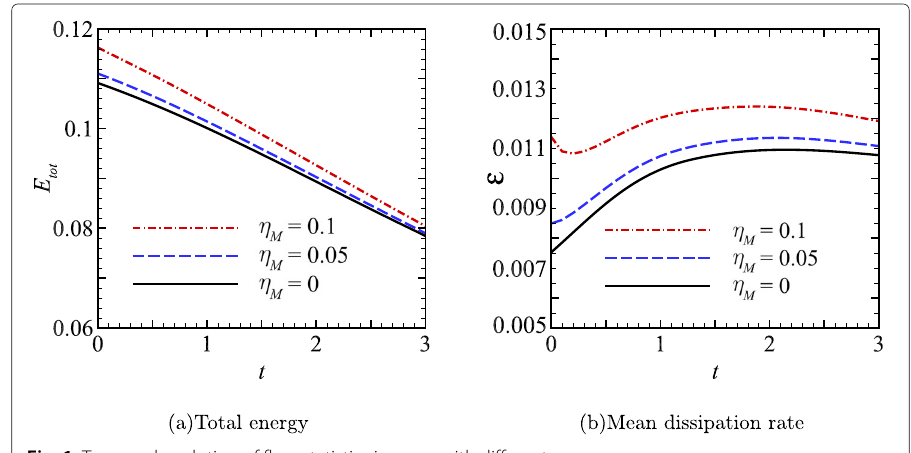
Fig. 1 Temporal evolution of flow statistics in cases with different η M